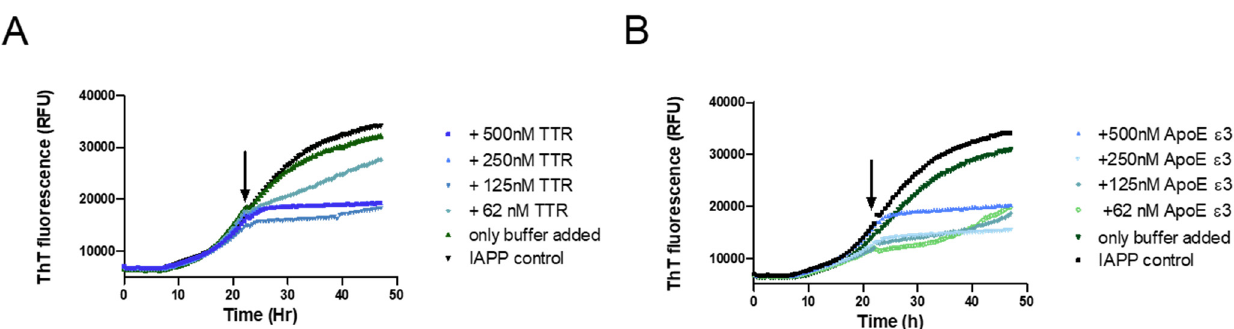
Figure 4. Probing the ability of TTR to inhibit the elongation process during IAPP amyloid formation. A total of 5 µ M of IAPP was incubated in phosphate-buffered saline and monitored for amyloid formation with the ThT fluorescence assay. At the timepoint indicated by the arrow, the respective proteins were added at the indicated concentrations: TTR L12P ( A ) recombinant Apolipoprotein E (ApoE) ε 3, serving as a positive control ( B ).